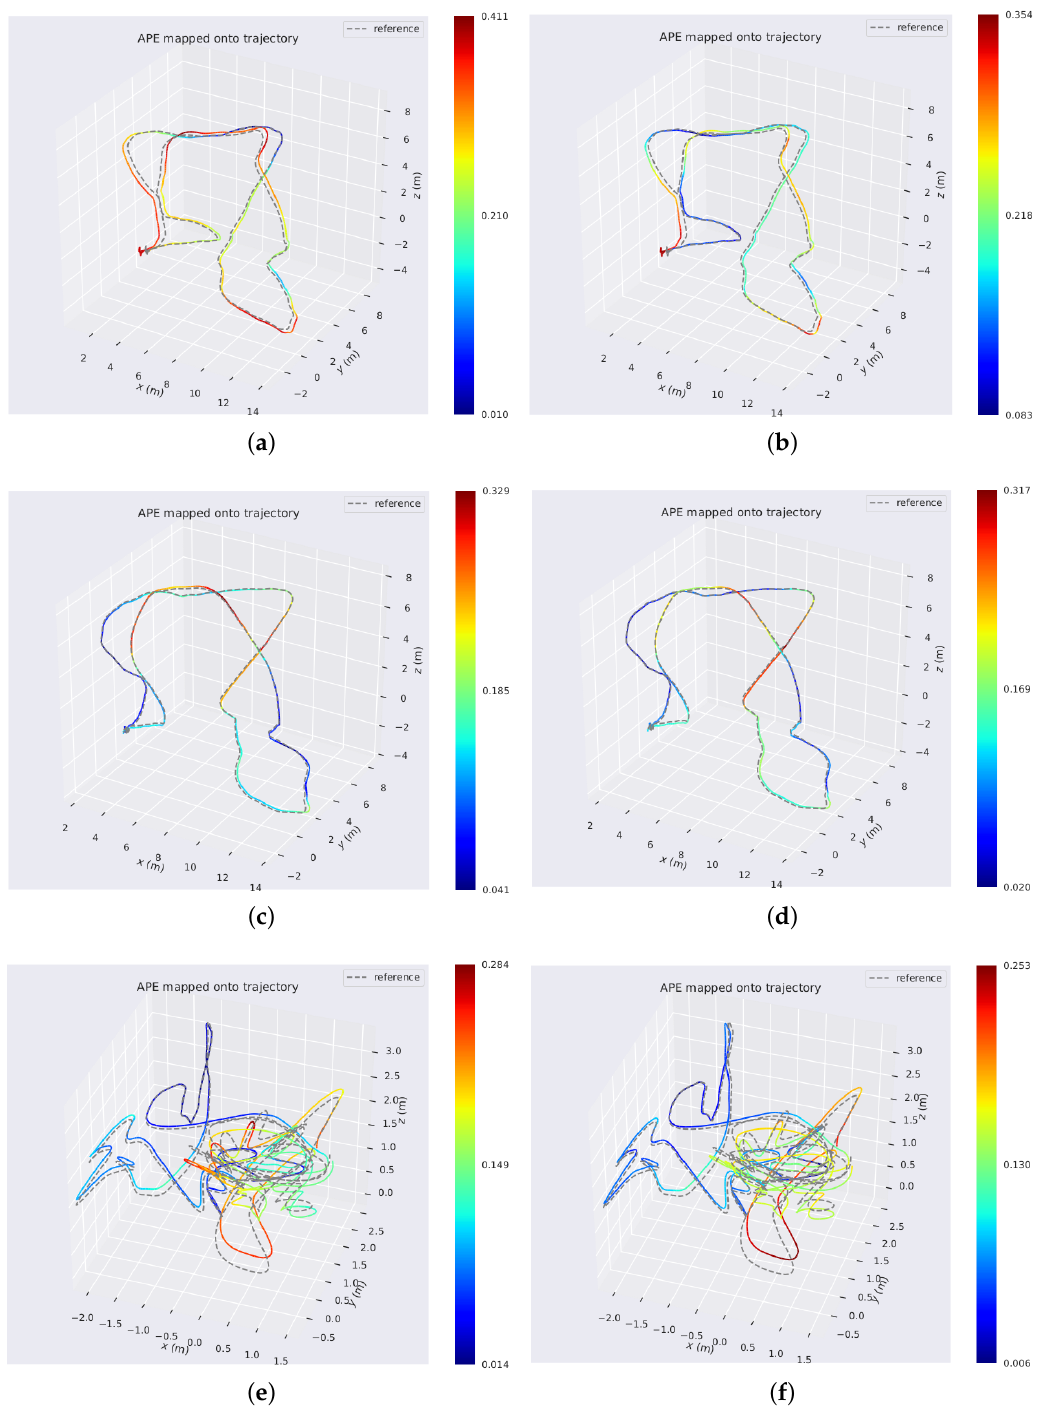
Figure 7. Comparison of the proposed method versus VINS-Mono. The three colorful trajectories of the left column are run with VINS-Mono on the ( a ) MH_05_difficult ; ( c ) MH_04_difficult ; and ( e ) V1_03_difficult sequences. The right three trajectories are the results of the proposed PL-VIO on the ( b ) MH_05_difficult ; ( d ) MH_04_difficult ; and ( f ) V1_03_difficult sequences. Colors encode the corresponding absolute pose